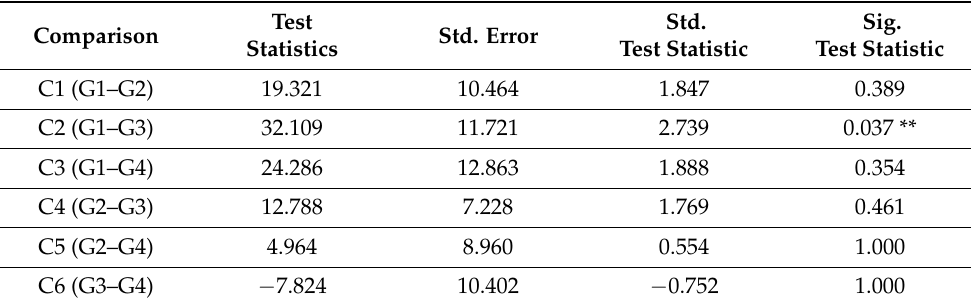
Table 5. Pairwise comparison